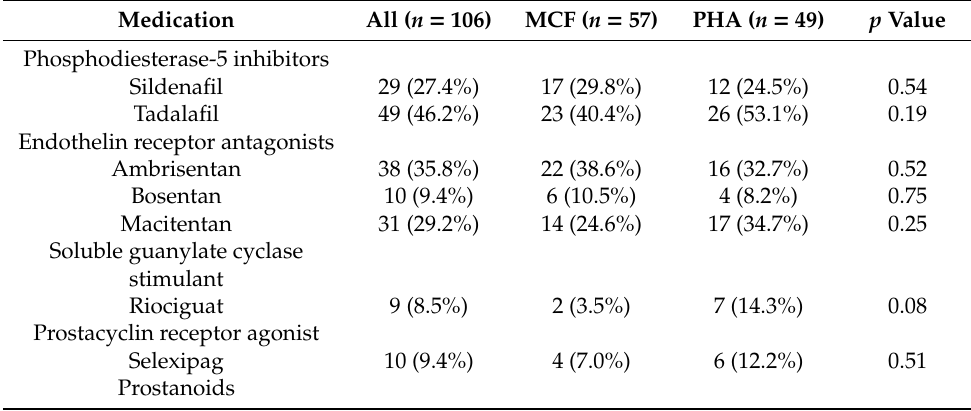
Table 2. Medication regimen for the